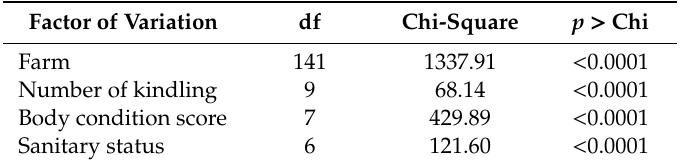
Table 5. The GENMOD (logit link function) of the risk factors farm, number of kindling, body condition score, week of lactation, and sanitary status for the prevalence of apparent infertility in rabbit